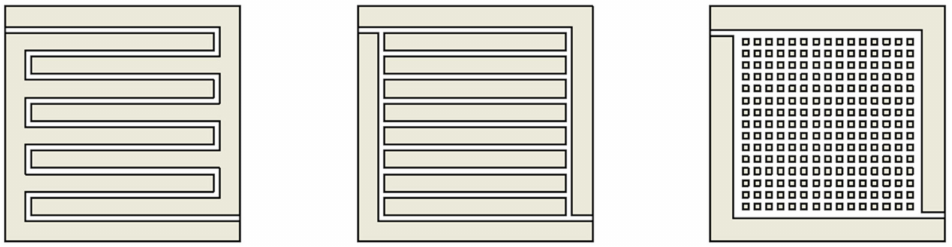
Figure 1. Common flow field designs: serpentine, columnar, and